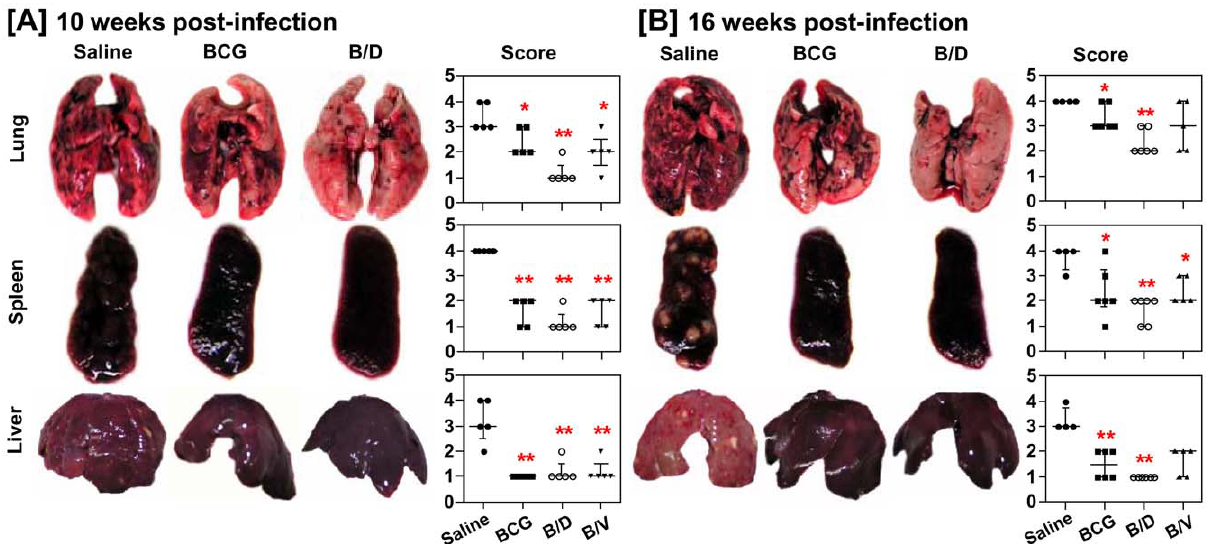
Figure 2. Influence of vaccination on gross pathology following M.tuberculosis infection. The figure depicts representative photographs and graphical depiction of gross scores of lung, liver and spleen of guinea pigs at (A) 10 weeks (n=5) and (B) 16 weeks (n=5) post-infection. Based on the extent of involvement, number and size of tubercles, areas of inflammation and necrosis, gross pathological scores were graded from 1 to 4. Each point represents score for an individual animal and the bar depicts median ( 6 inter-quartile range) for each group, * p , 0.05 and ** p , 0.01, when compared to the saline group (Mann-Whitney U test).